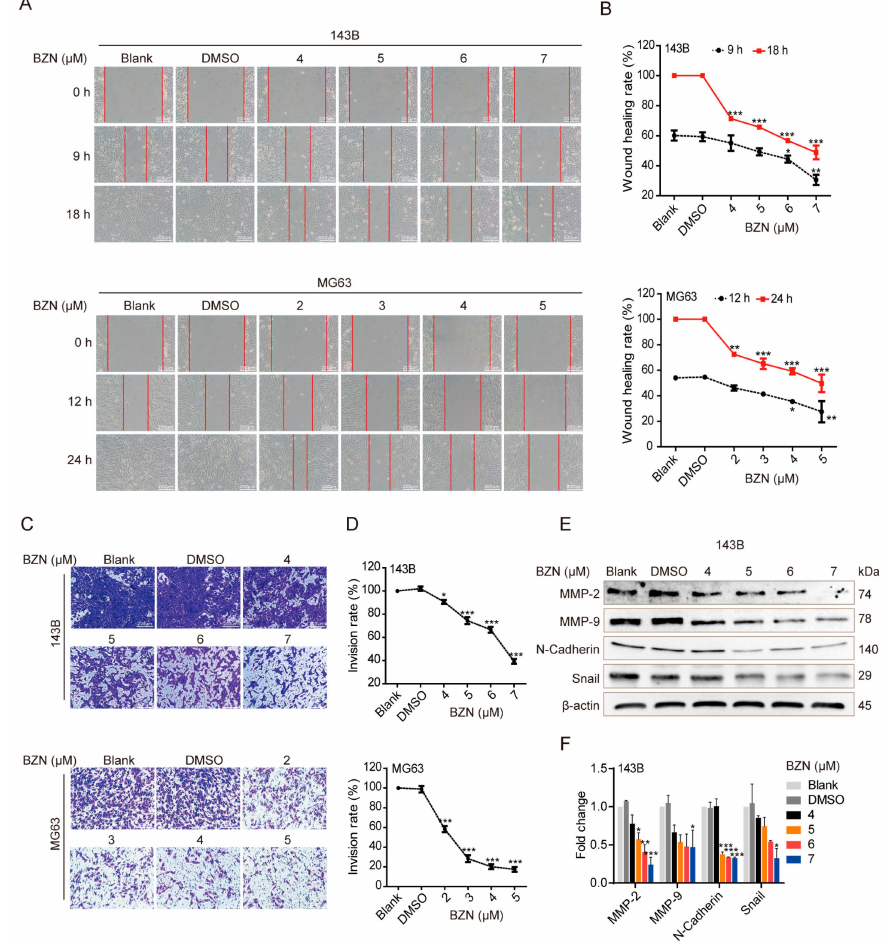
Figure 2. BZN inhibits the migration and invasion of OS cells. ( A ) The effect of BZN on the migration of OS cells (wound healing assay, scale bars: 200 µ m). ( B ) Quantitative analysis of wound healing rate. ( C ) The effect of BZN on the invasion of OS cells (transwell assay, scale bars: 200 µ m). ( D ) Quantitative analysis of invasion rate. ( E ) The effect of BZN on the protein levels of MMP-2, MMP-9, N-Cadherin, and Snail in 143B cells (Western blot). ( F ) Relative quantitative analysis of Western blot. Data are shown as mean ± SD from three independent experiments. * p < 0.05, ** p < 0.01, and *** p < 0.001 vs. DMSO